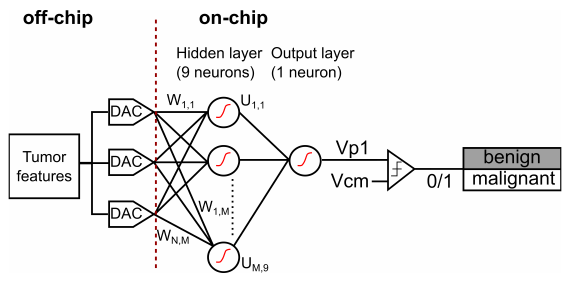
Figure 1. Proposed cancer classifier